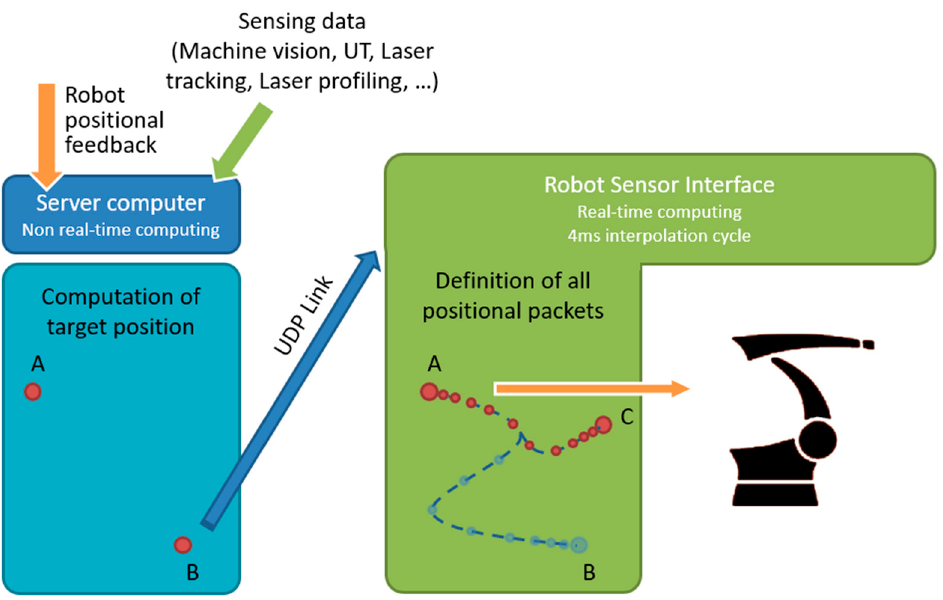
Figure 9. Robot Sensor Interface (RSI) for real-time computing in 4ms interpolation cycle. While moving from point A to point B, the robot can update its target position from current B to a new point C in real time.